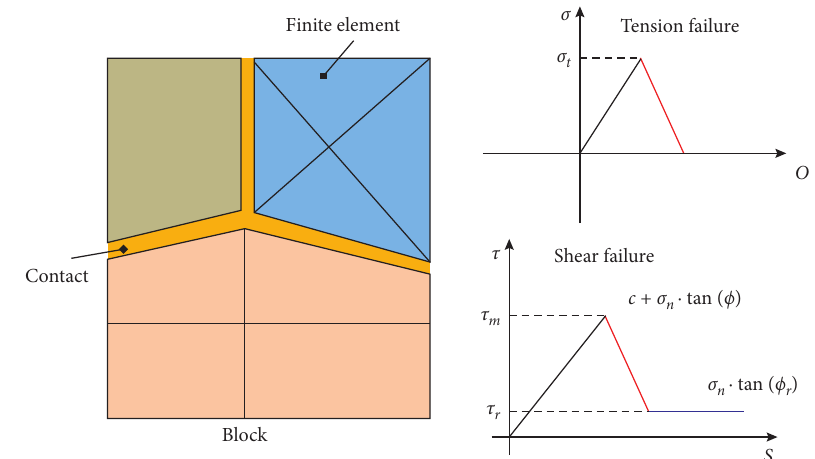
Figure 3: Schematic diagram of CDEM model.